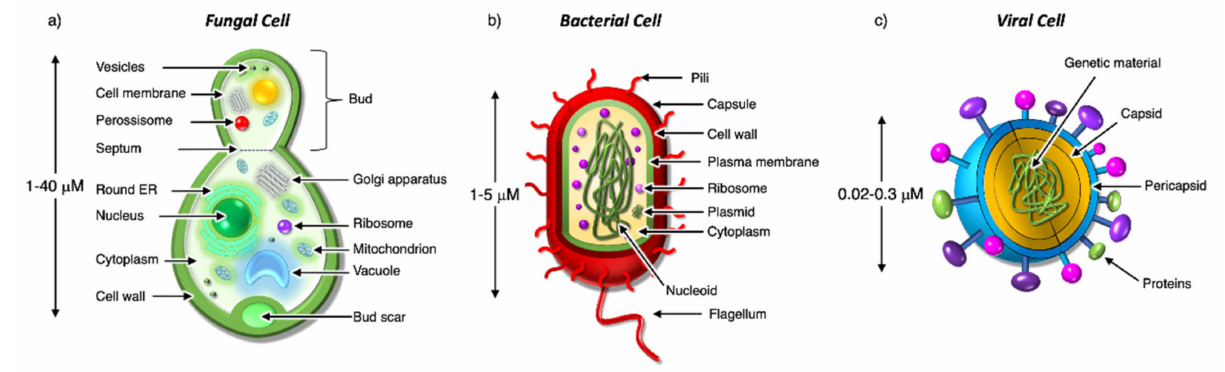
Figure 7. Schematic representation of some microorganisms: ( a ) fungal ( b ) bacterial, and ( c ) viral